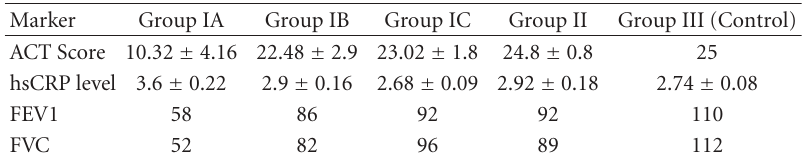
e ff ect begins at the third month of treatment [38,